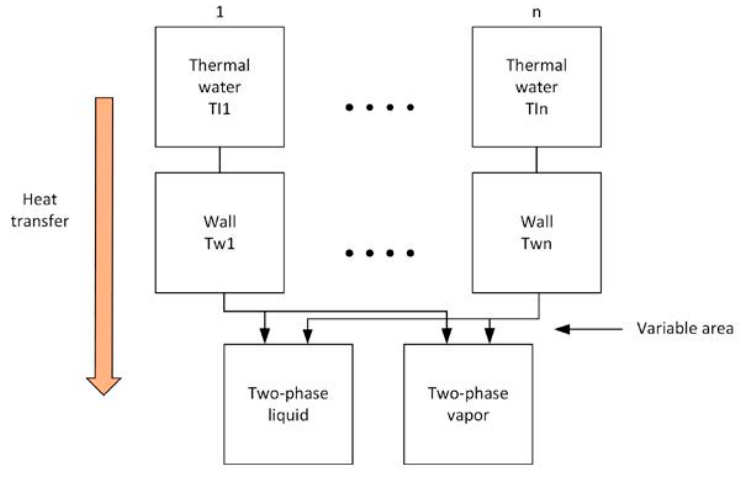
Figure 3. Heat transfer network for the kettle boiler.